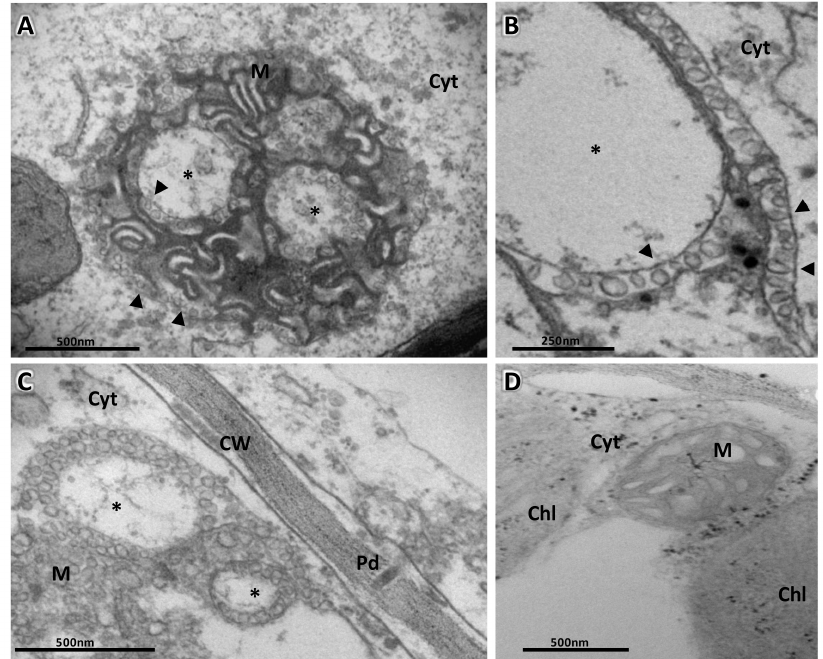
Figure 4. Transmission electron microscopy study of melon necrotic spot virus (MNSV)-infected cells from melon cotyledons. ( A ) Altered mitochondria (M) where the replication of the virus takes place, showing the presence of small vesicles (black arrow) inside large dilations (star) and around the periphery of the organelle. ( B ) Detail of a big dilation surrounded by bottlenecked vesicles connecting either with the dilation lumen or with the cytoplasm. ( C ) MNSV-altered mitochondria in the proximity of plasmodesmata. ( D ) Ultrastructure of a healthy plant mitochondria. Samples were taken 3 days post-inoculation. Notes: Chl, chloroplast; CW, cell wall; Cyt, cytoplasm; M, mitochondria; Pd, plasmodesmata. Scale bars are displayed with the images.